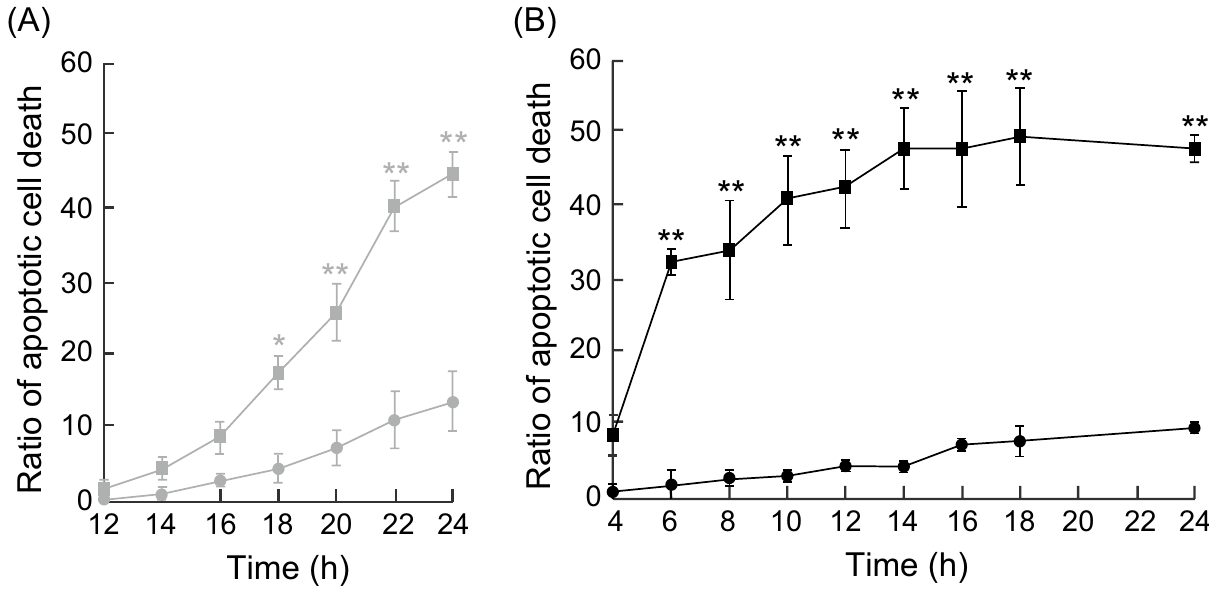
Figure 6. Ratio of time-dependent apoptosis in cells transfected by photoinduced cytosolic dispersion of RNA (PCDR) or lipofection. HeLa cells were transfected with pre-miRNA- U1A control or pre-miR-664a- U1A using Lipofectamine 3000 ( A ) or PCDR ( B ). Apoptotic cells were detected at 12, 14, 16, 18, 20, 22, and 24 h (lipofection) or 4, 6, 8, 10, 12, 14, 16, 18, and 24 h (PCDR). The ratio of apoptotic cells treated with pre-miRNA- U1A control by lipofection (gray circles), pre-miR-664a- U1A by lipofection method (gray squares), pre- miRNA control by PCDR (black circles), and pre-miR-664a- U1A by PCDR (black squares). Data represent the means ± SE of four (PCDR) or five (lipofection) independent experiments. *P < 0.05, **P < 0.01; P-values were calculated using two-way ANOVA and Tukey’s multiple comparisons test comparing pre-miR-664a- U1A with pre-miRNA- U1A control at each time